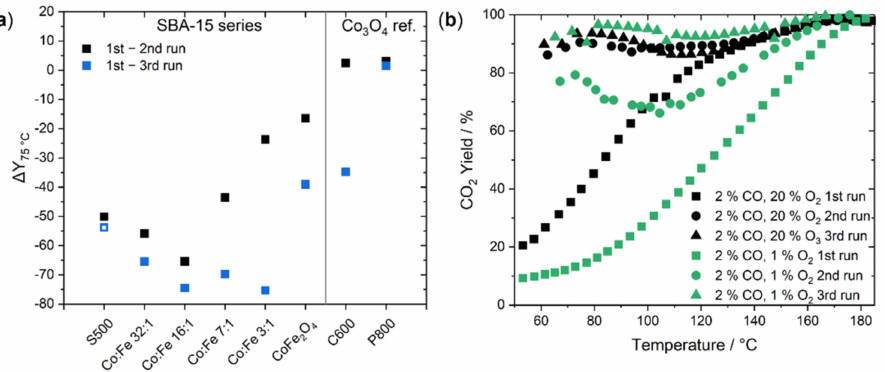
Figure 6. ( a ) Difference in conversion at 75 ◦ C between the 1st and 2nd/3rd run ( ∆ Y 75 ◦ C ) of CO oxidation for all catalysts. Please note that the conversion of S500 is 90% during the 2nd run, which is why it cannot be excluded that the improvement of this sample is to some extent limited by approaching full conversion, and the data point is shown as a hollow symbol. ( b ) CO oxidation activity of S500 in all runs for feed compositions 2% CO and 20% O 2 and 2% CO and 1% O 2